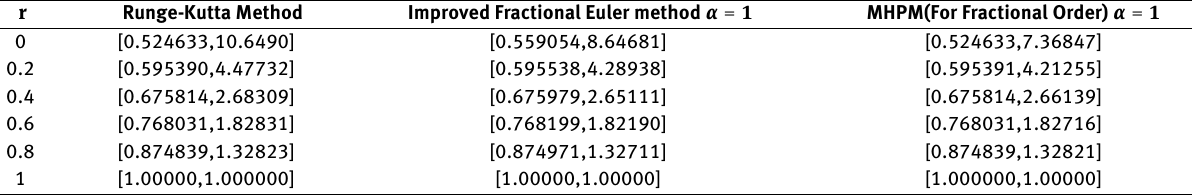
Table 5. Solutions obtained by Runge kutta method, MHPM and IFEM for h = 0.1 at t = 1 . r Runge-Kutta Method